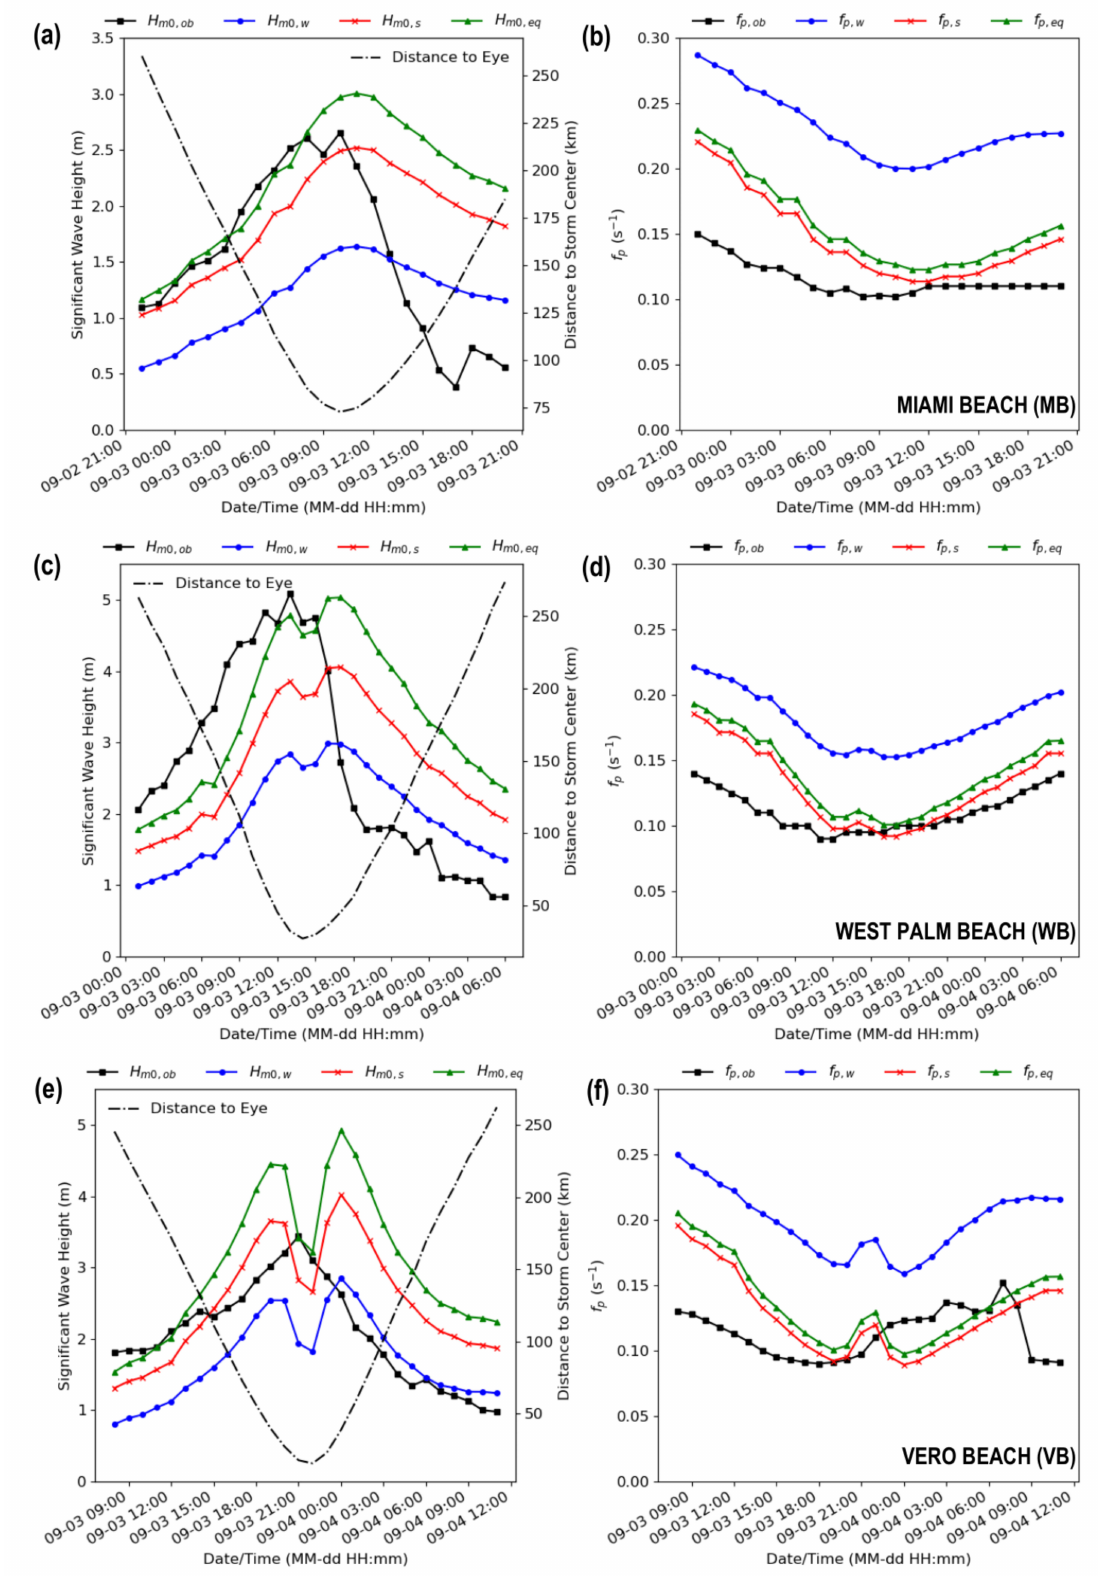
Figure 6. Wind-sea (subscript w ), swell (subscript s ), and combined swell/wind-sea (subscript eq ) parametric results per- taining to the ( a , c , e ) significant wave height ( H m 0 ) and ( b , d , f ) peak frequency ( f p ) when compared against site observations (subscript ob ) at Miami Beach (MB), West Palm Beach (WB), and Vero Beach (VB)